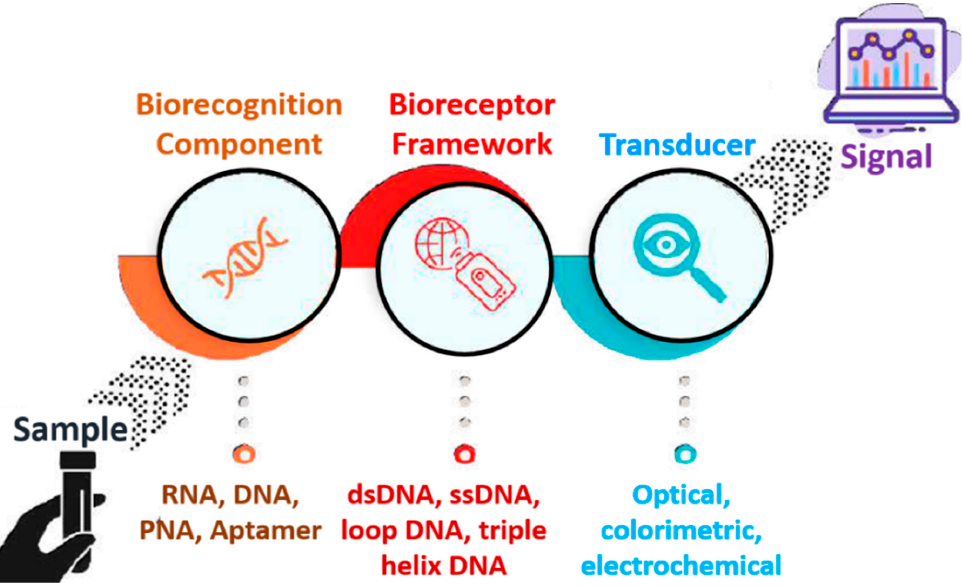
Figure 2. Classification of nucleic acid-based biosensors for detection of nucleic acid.